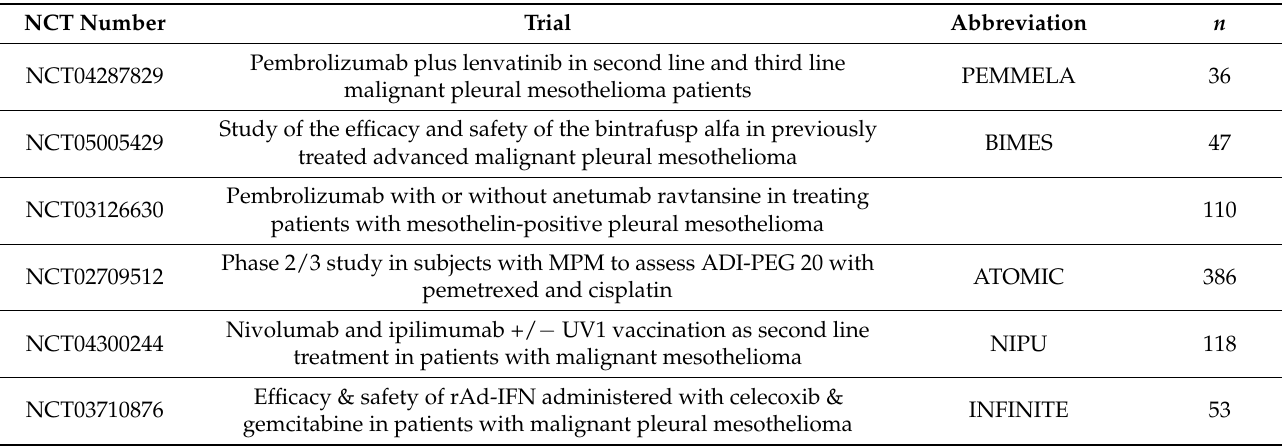
Table 4. Selected ongoing trials in salvage